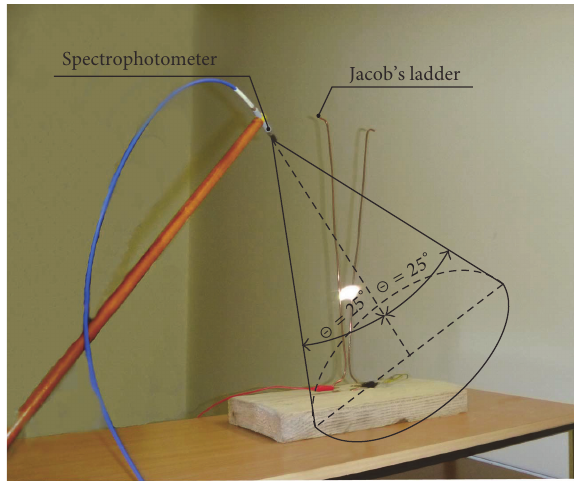
Figure 3: Picture of the object under study and optical fibre assembly. The acceptance angle of the optical sensor is 50deg.